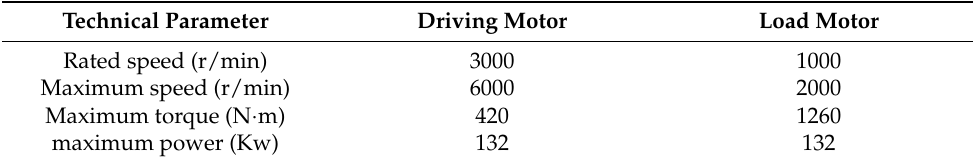
Table 3. Technical parameters of motor.